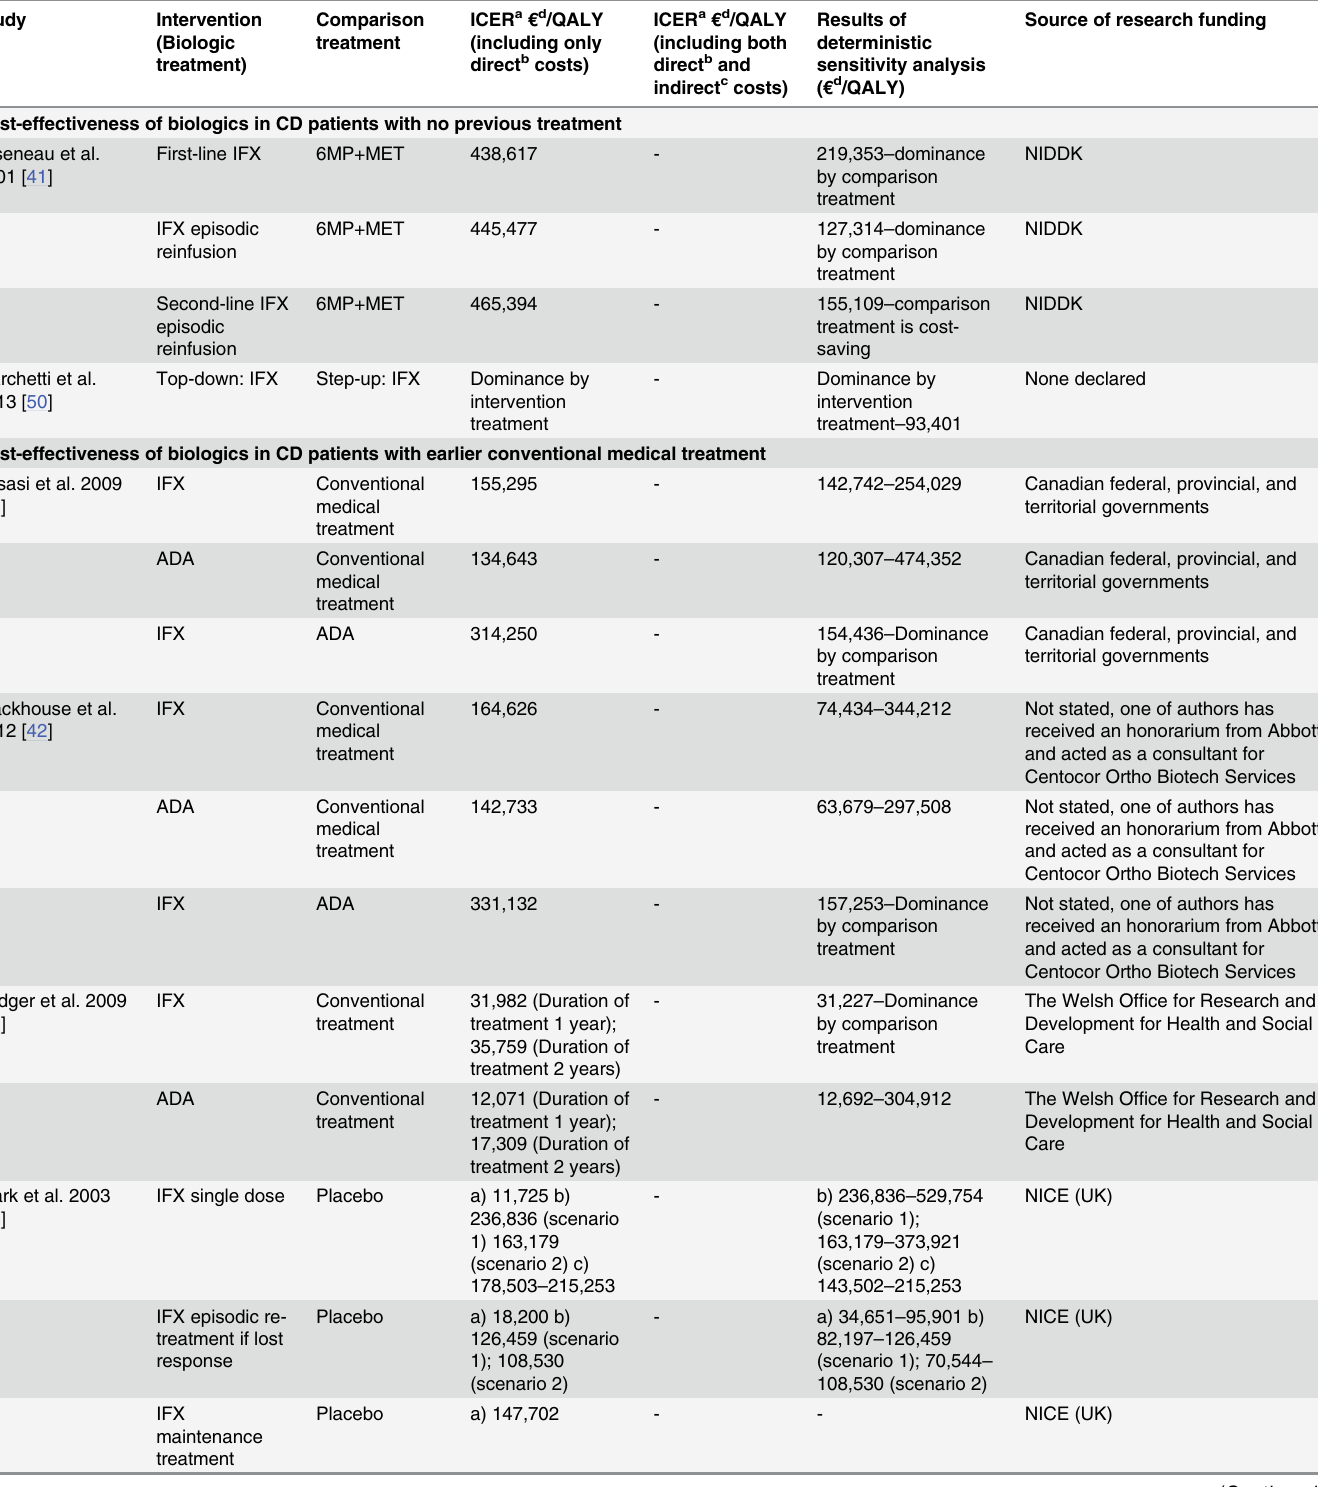
Table 2. Cost-effectiveness of biologics for the treatment of Crohn ’ s disease (CD).